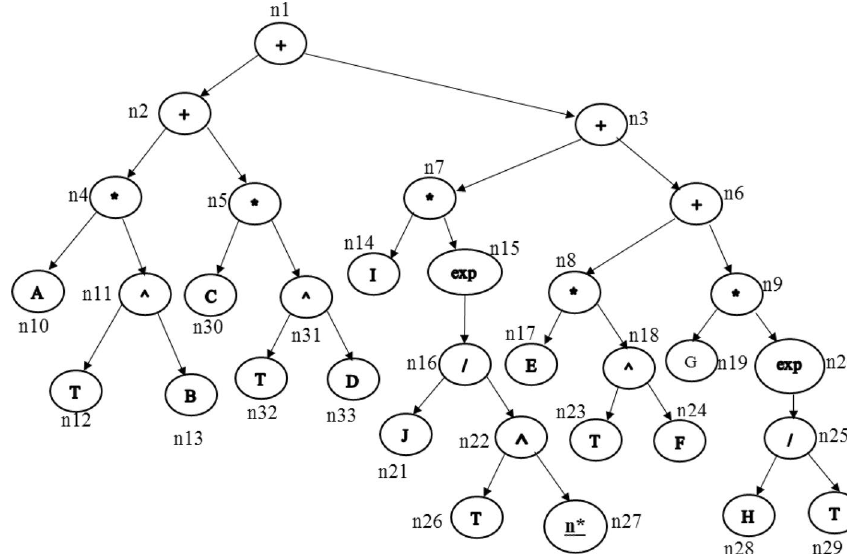
Fig. 2 Tree structure for devel- oped correlation, *represents a tuned